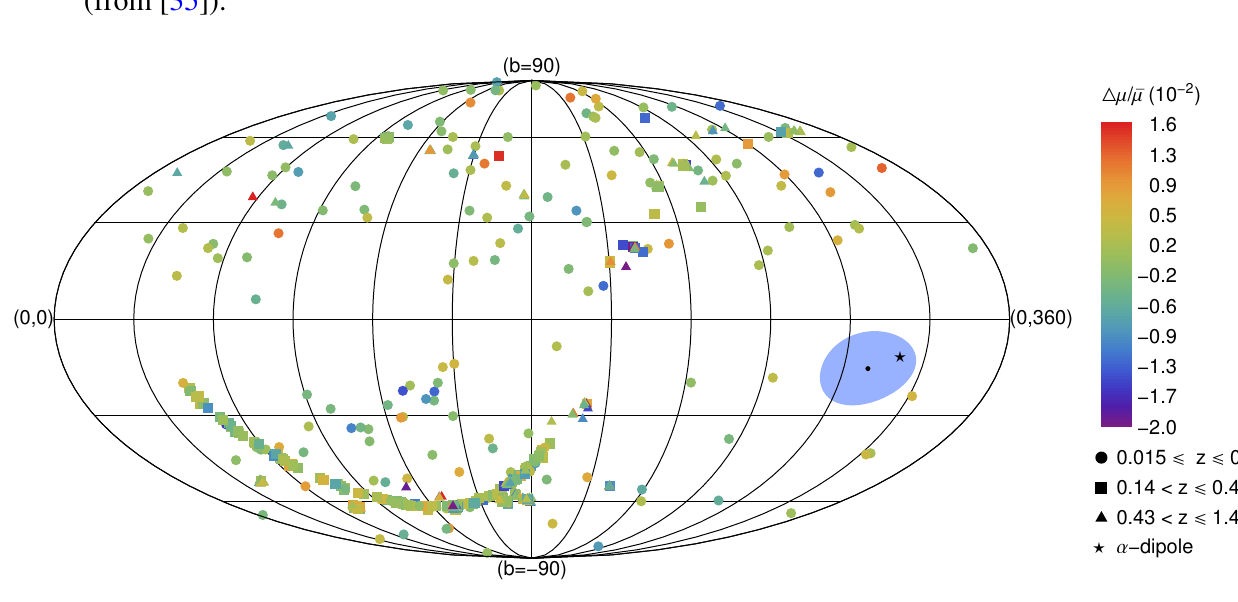
Figure 2. The distribution of the Union2 SnIa datapoints in galactic coordinates along with the Dark Energy dipole direction are shown. The datapoints are split in three different redshift bins shown with different shapes. The direction of the α -dipole is also shown with a star. The light blue blob represents the 1- σ error on the Dark Energy dipole direction (from